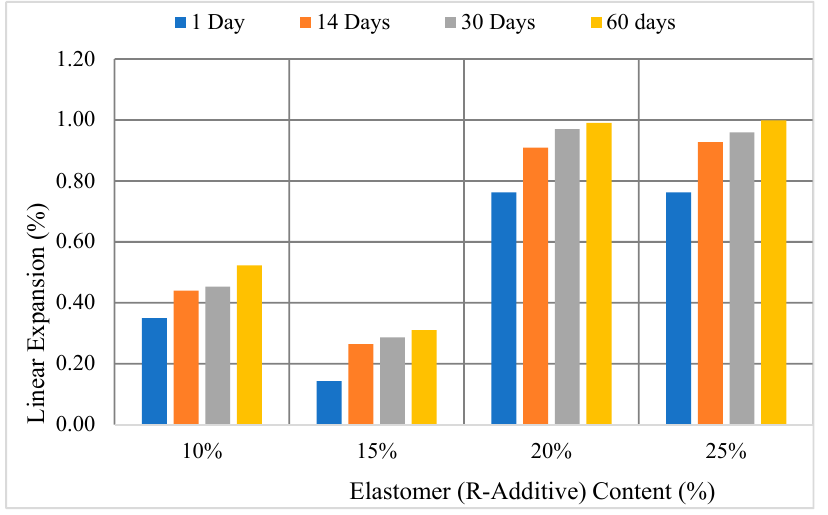
Figure 6. Effects of elastomer (R-Additive) content on the linear expansion.